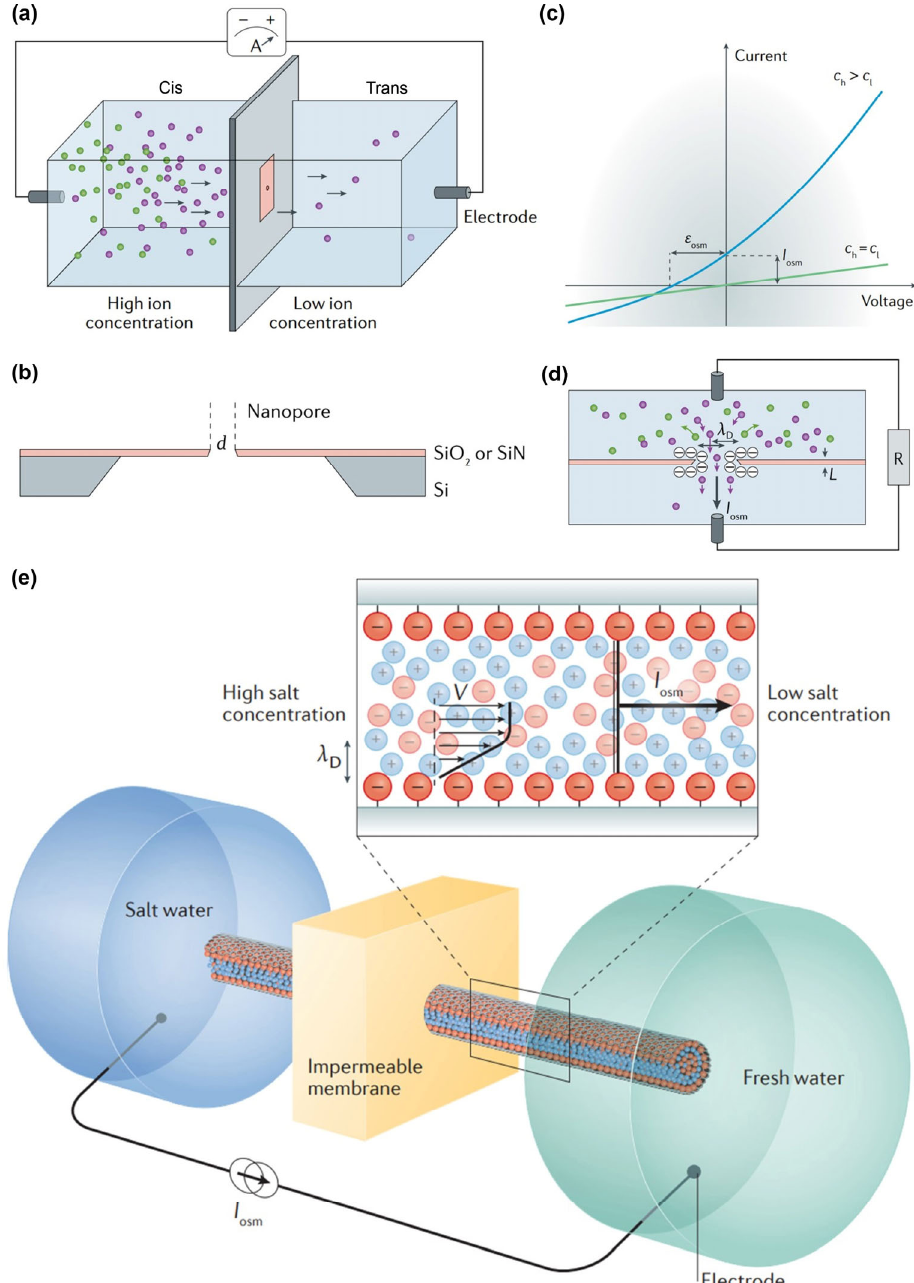
Figure 2 A thin membrane is placed across two reservoirs with a salinity gradient that is connected via Ag/AgCl electrodes (a). The schematic diagram of a nanofluidic channel which is comprised of thin atomic layers with nanopores, placed on a supporting window (b). Typical I–V curves under an osmotic gradient (blue curve) and no osmotic gradient (green curve) (c). A thin 2D membrane with a nanopore that shows selective ion transportation (d). Reproduced with permission from Ref. [31], © Springer Nature Limited 2019. The diffusio-osmotic mechanism in a charged nanofluidic channel (e). Reproduced with permission from Ref. [40]. © Macmillan Publishers Limited